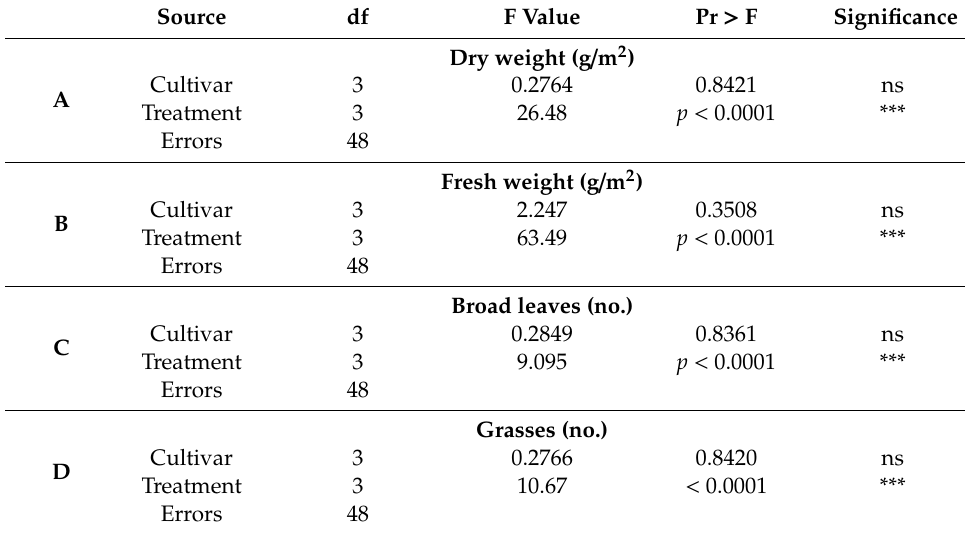
Table 1. ANOVA results for total weed biomass (fresh and dry weights) weed density (number of broadleaves, grasses, and